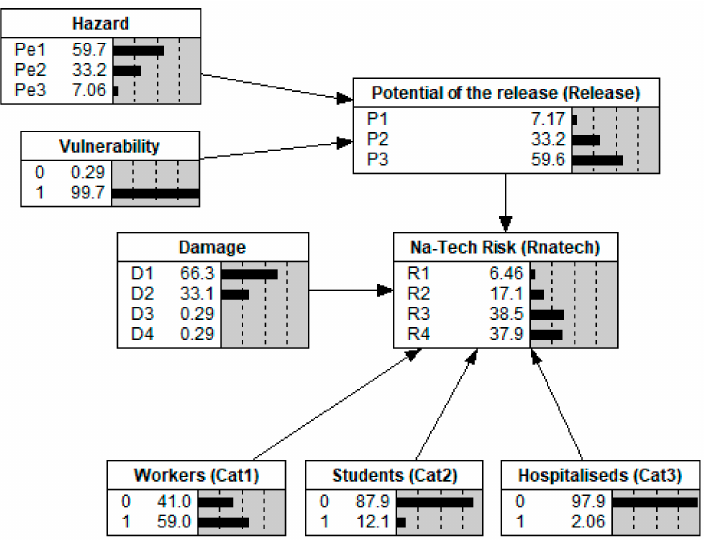
Figure 7. Implementation of the Na-Tech model in a Bayesian